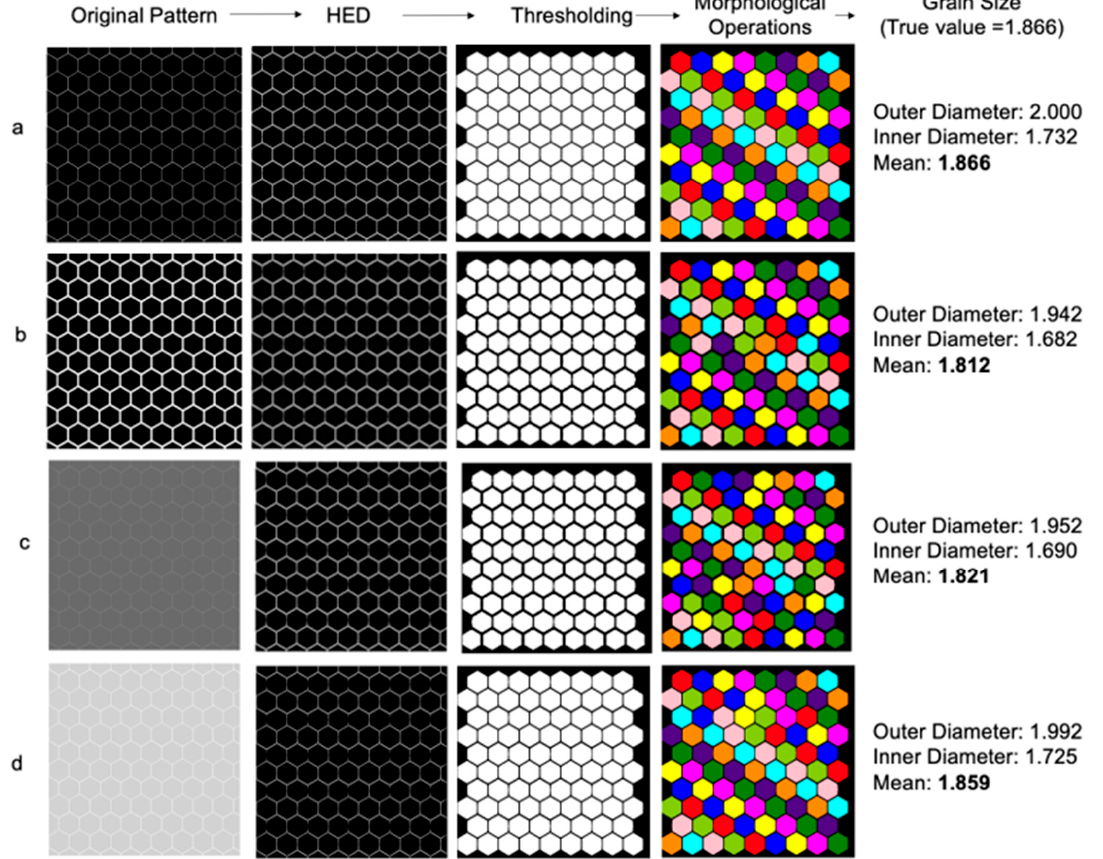
Figure 3. Mean diameter determination of honeycomb structure ( a ) with an expected value of 1.866 units. Alterations of the initial figure include sidewall thickening ( b ), low-intensity low con- trast ( c ), and high-intensity low contrast ( d